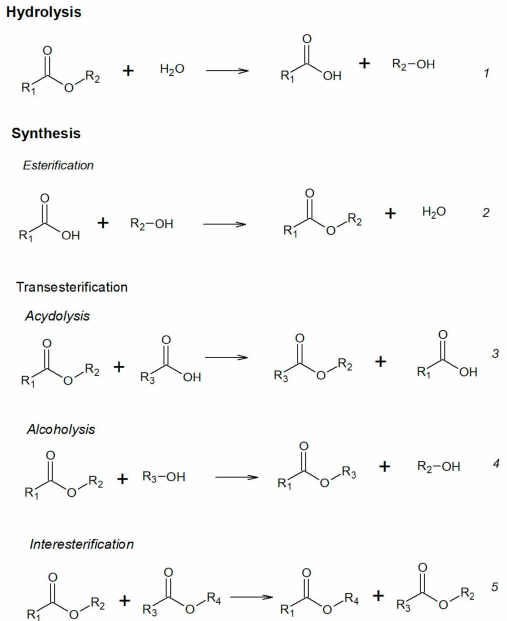
Figure 1. Examples of reactions catalyzed by lipases. Hydrolysis (1) is the most prevalent re- action in aqueous media, whereas synthesis reactions (2–5) can occur in non-aqueous media (ACD/ChemSketch (Freeware) version 2018.2.1, Advanced Chemistry Development, Inc., Toronto, ON,